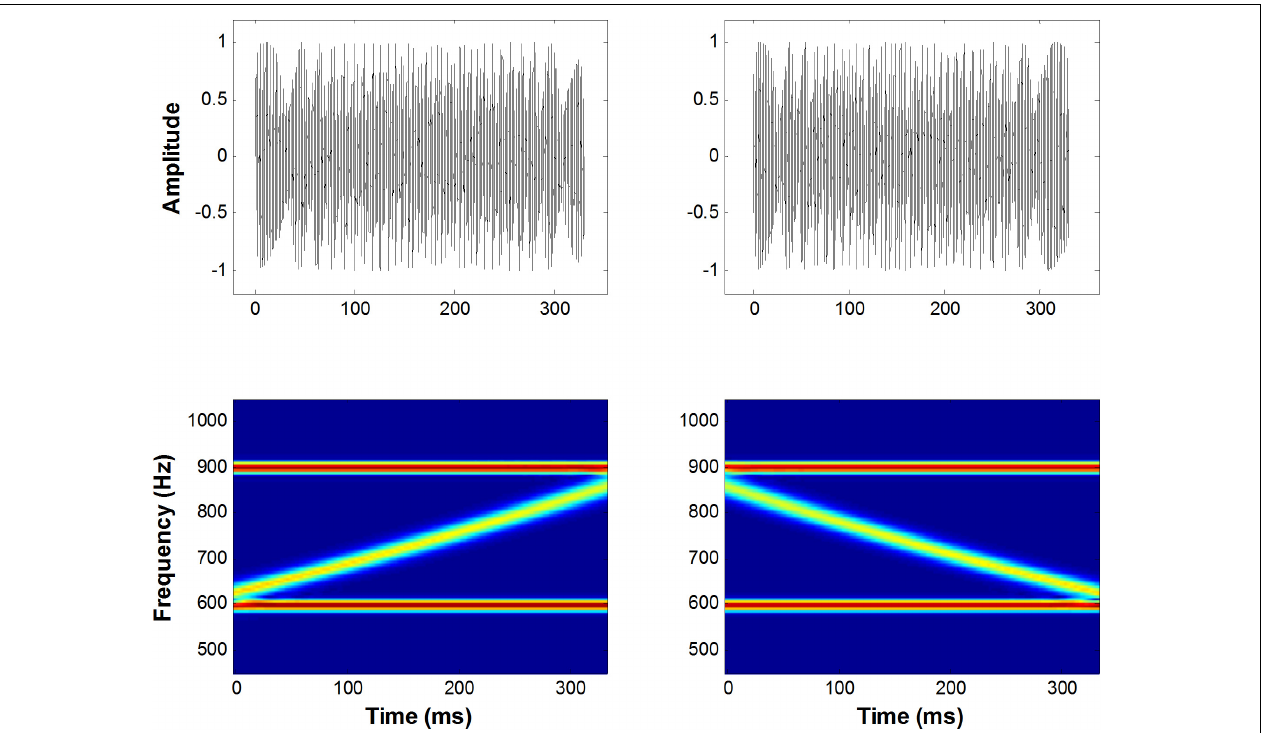
FIGURE 1 | A schematic representation of the up and down FM sweep complex. The left panel shows an amplitude spectrum (top) and a spectrogram (bottom) for upward FM sweeps in a frequency range of 600–900 Hz, bounded by two fixed-frequency pure tones. The right panel shows the same illustration for downward FM